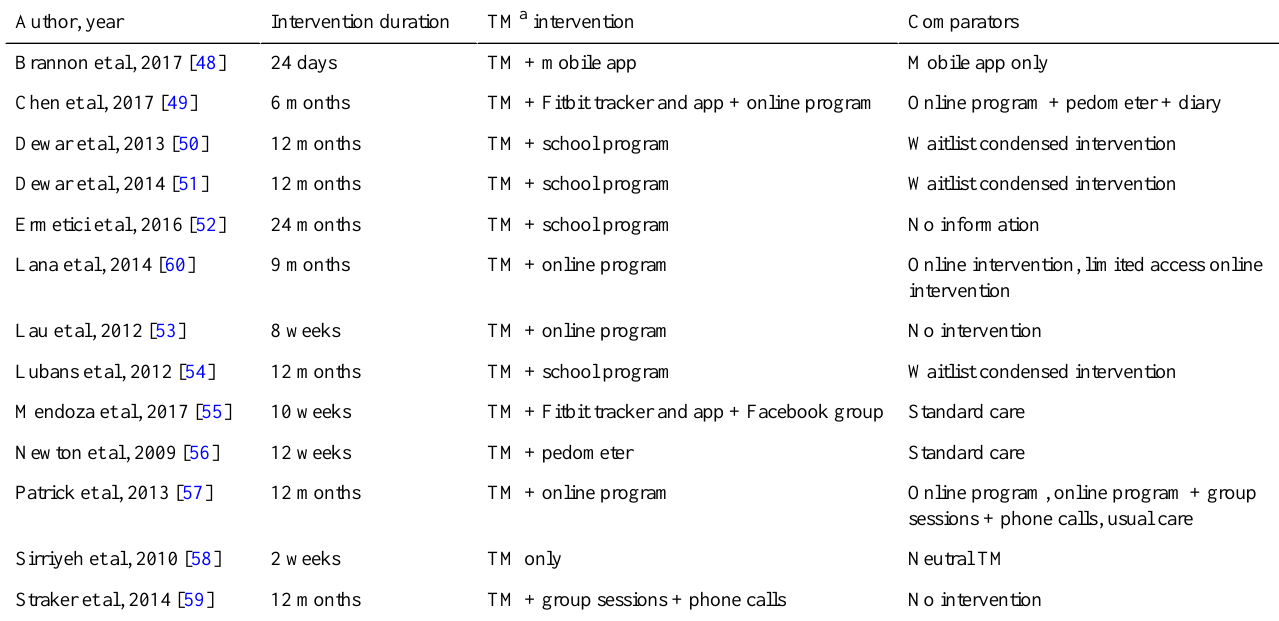
Table 3. Study characteristics of included studies—intervention and comparator.